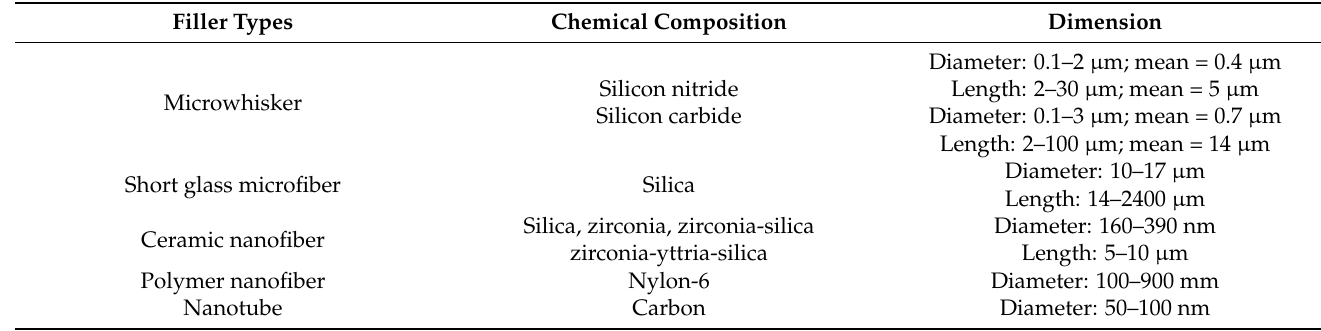
Table 2. Characteristics of various fibrous fibers.